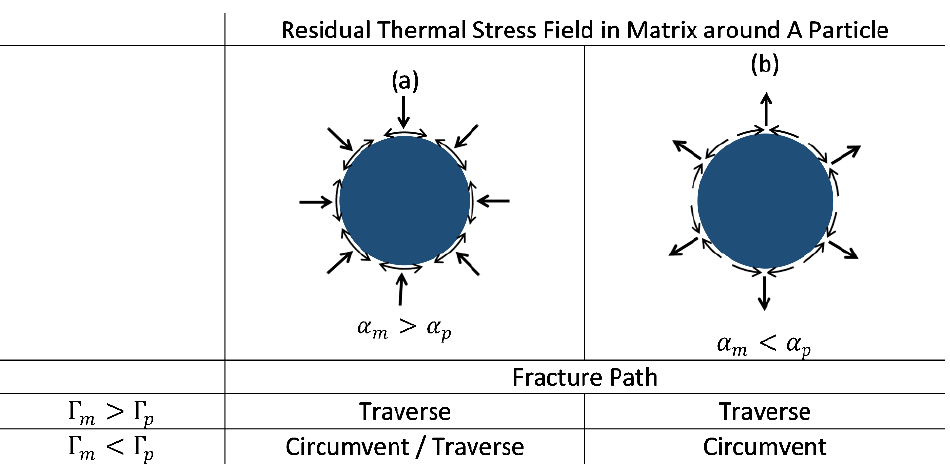
Figure 14. Schematic of residual stresses in matrix around a single embedded particle, which arise due to thermal expansion mismatches during cooling. In the schematic, coefficient of thermal expansion for the matrix α m and the particle α p are non-equivalent. Panal ( a ) depicts the scenario when α m > α p , and Panal ( b ) depicts the scenario when α m < α p . Recreated from [141].